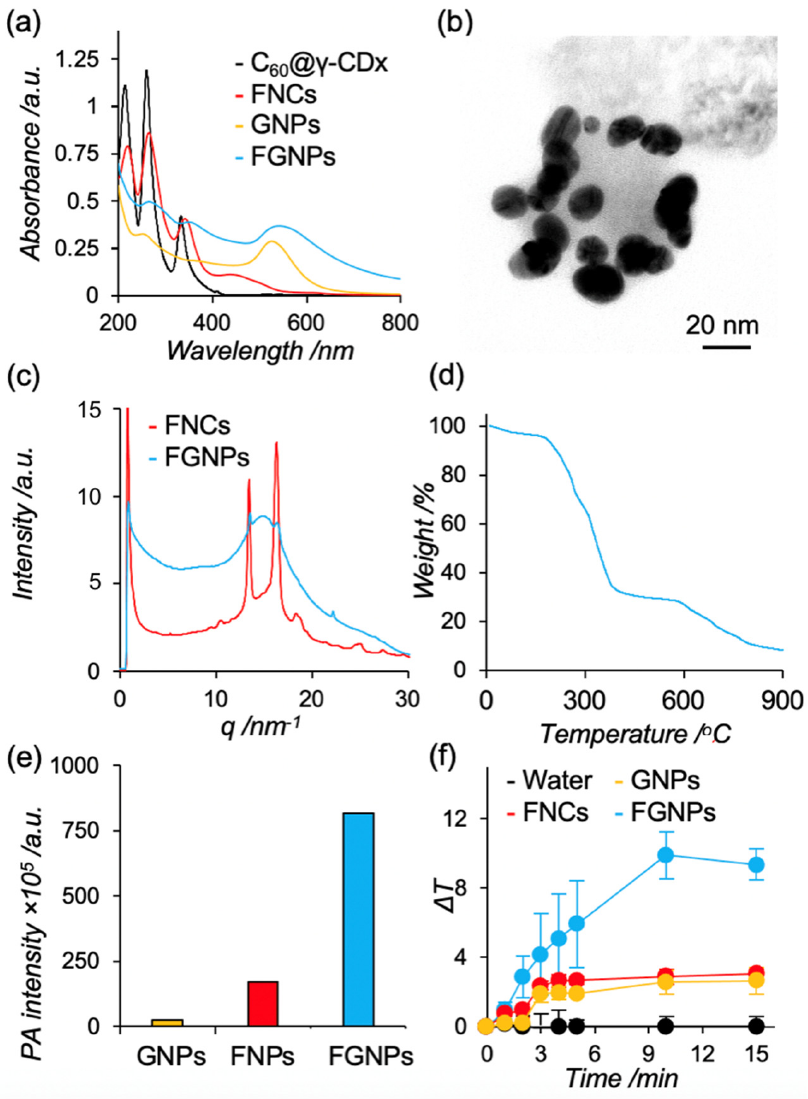
Figure 2. Basic characterization of FGNPs. ( a ) UV-Vis absorption spectra of C 60 / γ -CD (black), FNPs (red), GNPs (yellow), and FGNPs (blue) (C 60 , 1 mM; γ -CD, 2 mM; gold, 300 ppm). ( b ) Representative morphology of FGNPs. The samples were observed without staining by TEM (accelerate voltage, 80 kV). The scale bar represents 20 nm. ( c ) The 1D WAXS intensity profiles of FNPs (red) and FGNPs (blue). The detector was placed 0.098 m away from samples. The wavelength of the incident beam was 0.1 nm. The measurement was carried out at 25 ◦ C with an exposure time of 180 s. ( d ) Thermogravimetric curve of FGNPs. ( e ) Photoacoustic signals of GNPs (yellow), FNPs (red), and FGNPs (blue). The samples were excited at 680 nm (C 60 , 1 mM; Gold, 300 ppm). ( f ) Photothermal heating characteristics of FNPs, GNPs, and FGNPs. Water (black) and dispersion of FNPs (red), GNPs (yellow), and FGNPs (blue) were exposed to light with optimal wavelength (>620 nm, 5 W · cm − 2 ) (C 60 , 1 mM; Gold, 300